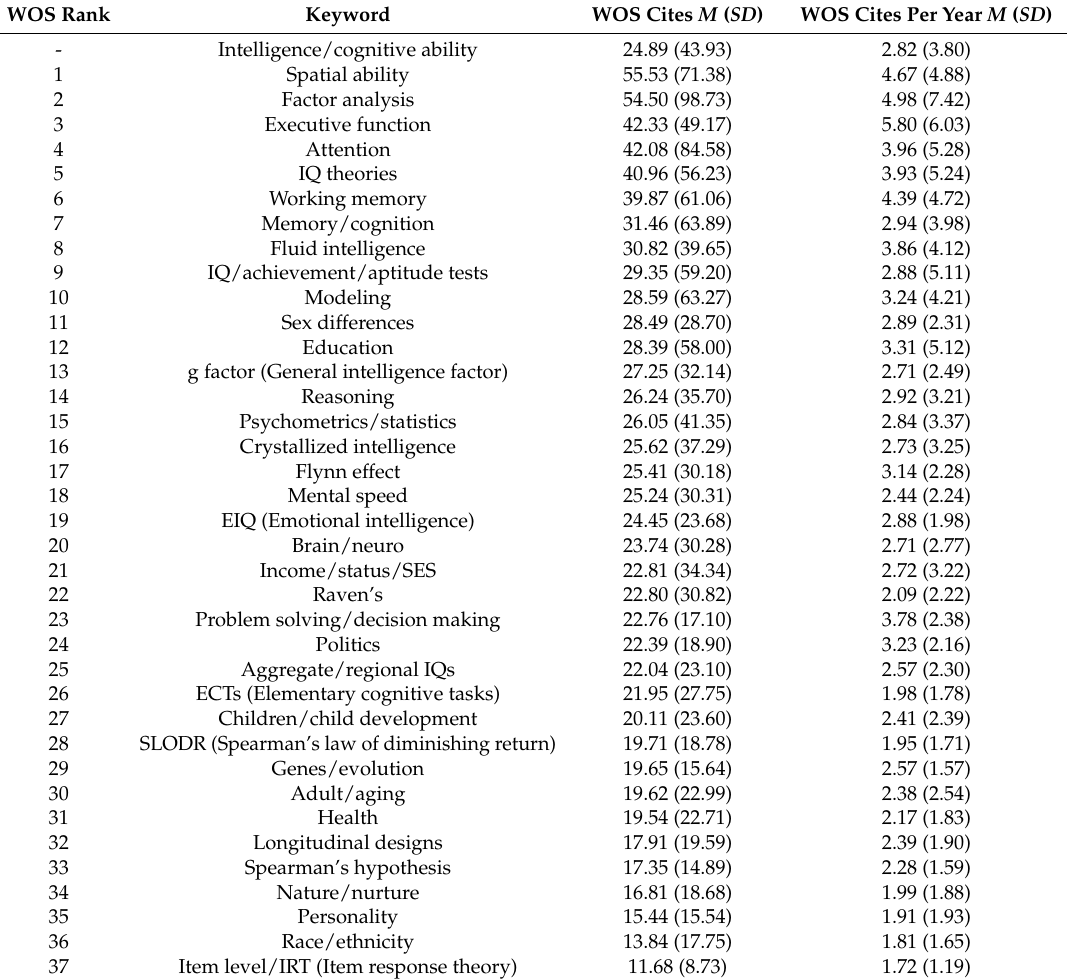
Table 2. Mean Web of Science (WOS) citation counts for articles with specific keywords. WOS